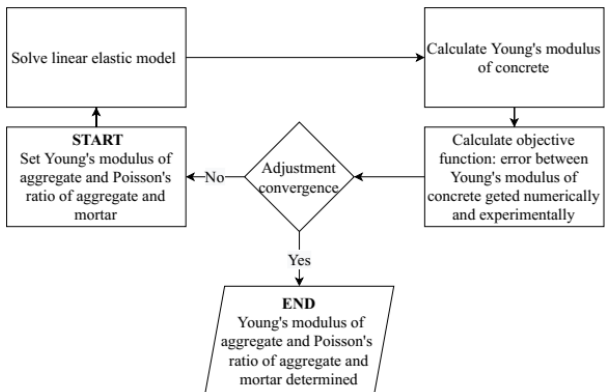
Figure 2. Flowchart 1: Linear elastic model – estimation of the unknown mechanical properties: Young's modulus of aggregate and Poisson's ratio of aggregate and mortar, for the initial temperature.